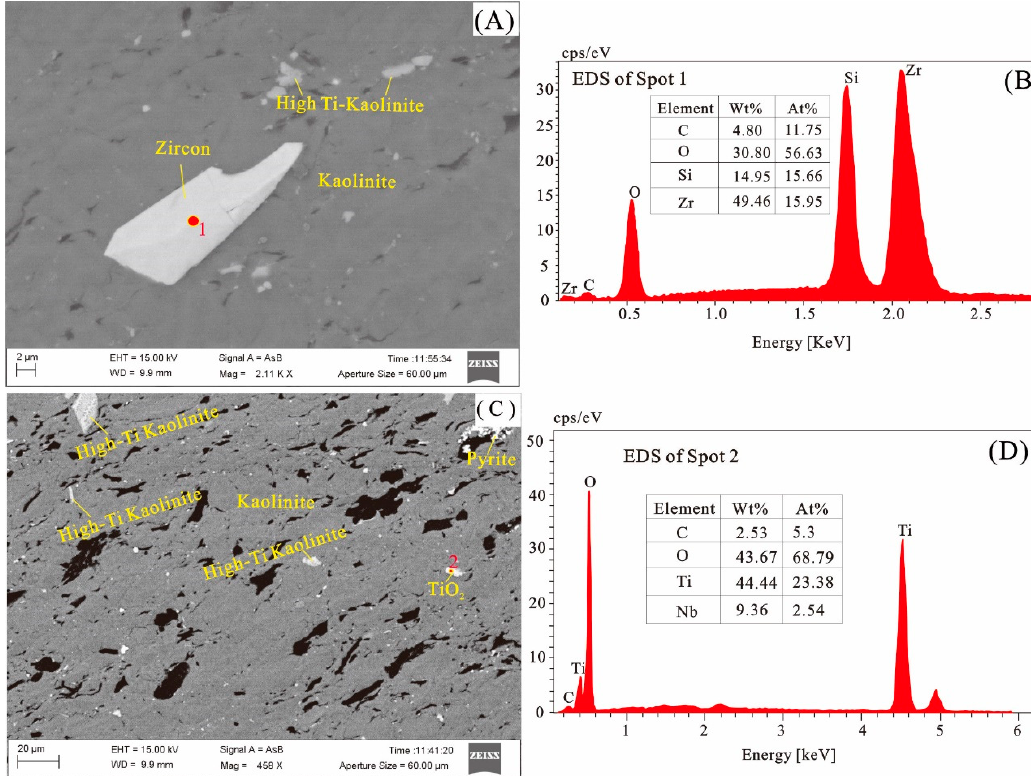
Figure 11. Characteristics of the Zircon and Anatase / Rutile in the Dongpo Mine samples. ( A ) Zircon and high-Ti kaolinite in sample DP5 − 2 -3-p. ( B ) EDS spectrum of Spot 1. ( C ) Anatase / Rutile, pyrite, and kaolinite in sample DP5 − 2 -3-p. ( D ) EDS spectrum of Spot Table 3. Low temperature ash yields (LTA, %) and mineral compositions (%) of the LTA samples, partings, roof, and floor samples from XRD analysis.